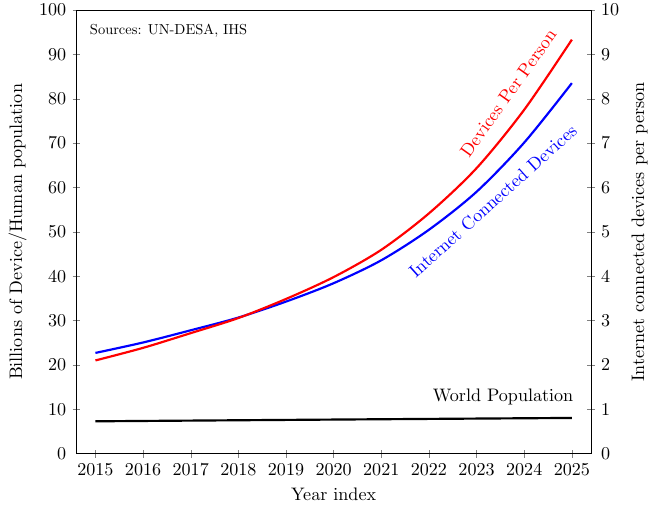
Figure 1. Internet-of-Things (IoT)-enabled devices connected to the